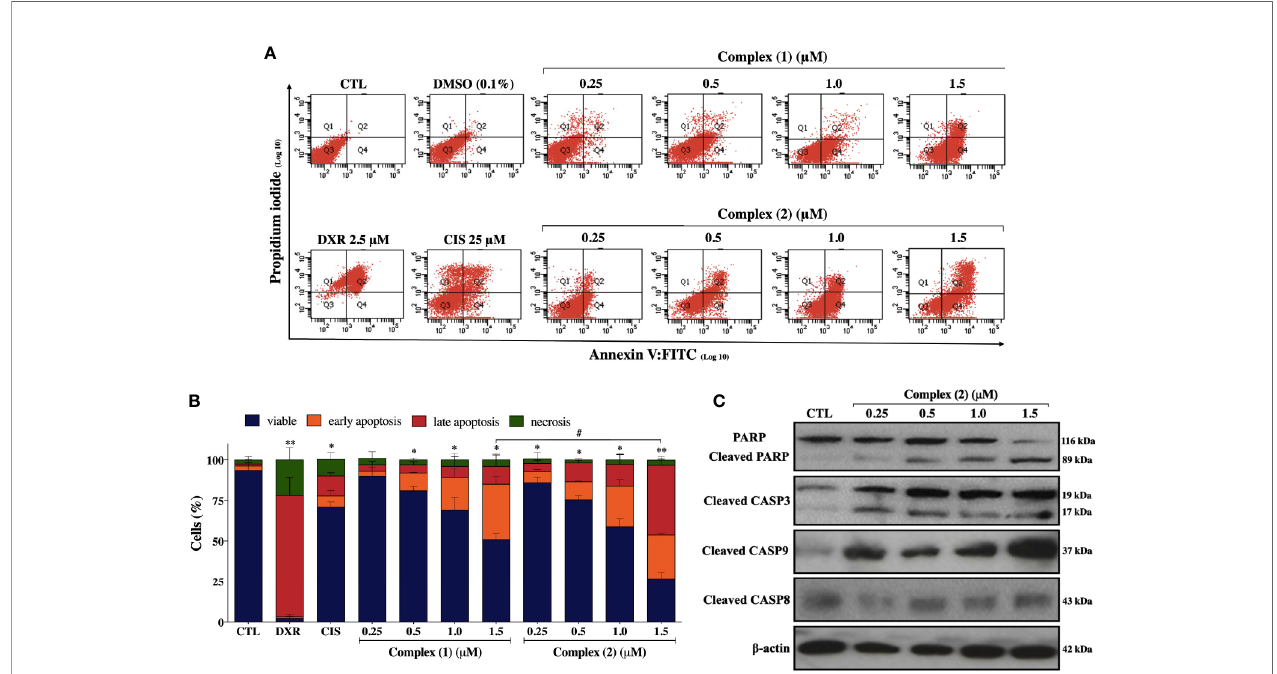
FIGURE 4 | Lapachol-containing ruthenium complexes induces apoptosis in DU-145 cells. (A) Representative fl ow cytometry dot plots show the presence of cells on viable (Q3), early apoptotic (Q4), late apoptotic (Q2) and necrotic (Q1) stages and, (B) showed the summary data determined by fl ow cytometry using annexin V-FITC/PI staining. Data are presented as the means ± S.E.M. of three independent experiments performed in triplicate. Ten thousand events were evaluated per experiment, and cellular debris was omitted from the analysis. (C) Western blot analysis showing the expression and activation status of cleaved PARP as well as cleaved caspase-3 and -9 levels in prostate adenocarcinoma cells after treatment with complex ( 2 ) for 24 h. The densitometric analysis of gray bands is shown in Supplementary Figure 11 . The negative control (CTL) was treated with the vehicle (0.1% DMSO) used for diluting the tested compound and, doxorubicin (DXR 2.5 m M) and cisplatin (CIS 25 m M) were used as drug control. Two-way ANOVA followed by Dunnett ’ s post-test where, * p < 0.05 vs. apoptotic cells in CTL; ** p < 0.01 vs. apoptotic cells in CTL; # p < 0.05 apoptotic cells after 1.5 m M of complex ( 1 ) vs. apoptotic cells after 1.5 m M of complex ( 2